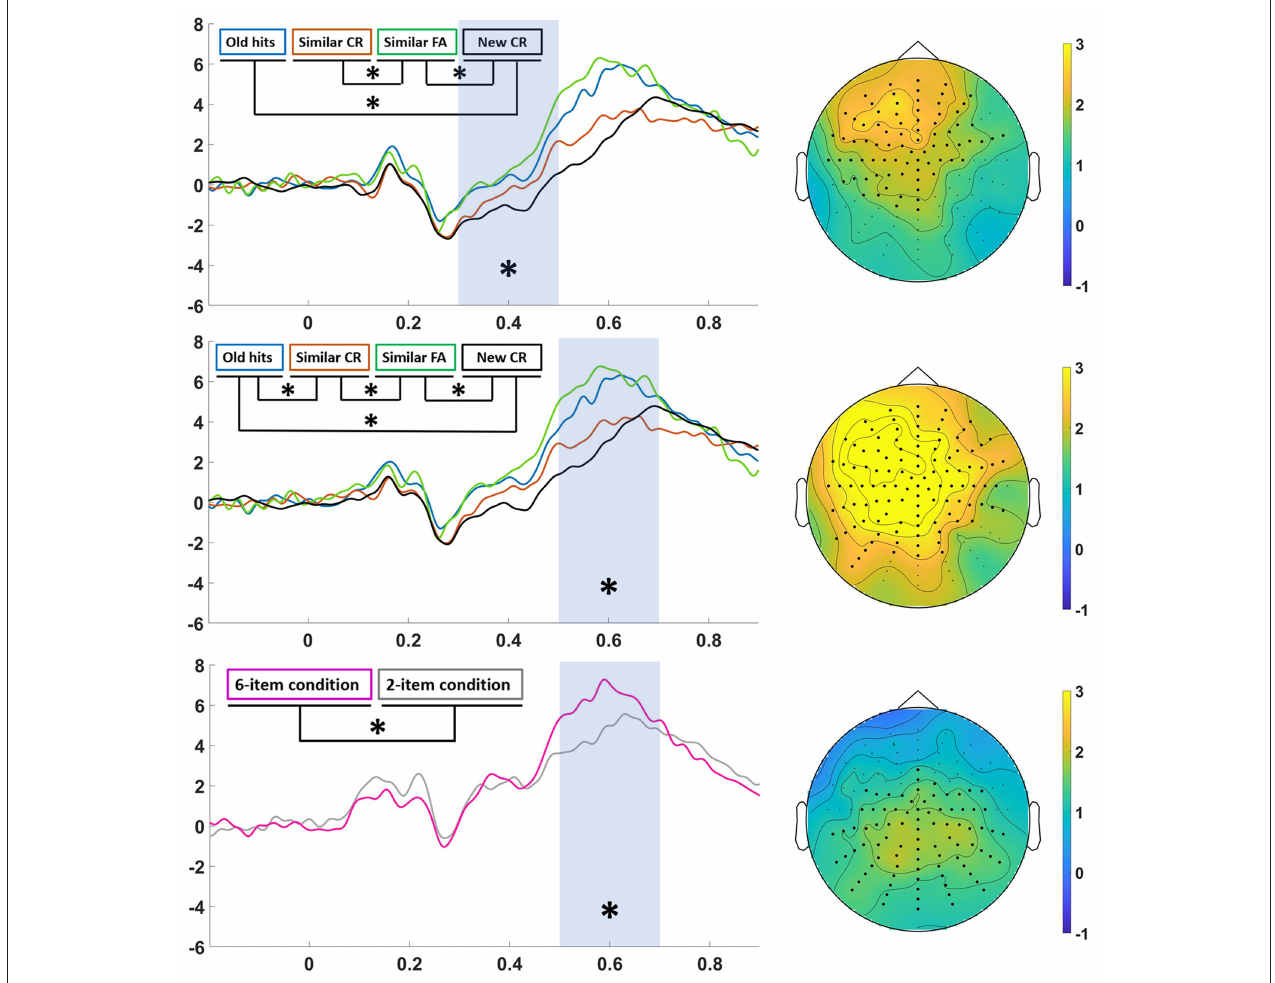
FIGURE 4 | Analysis in the 20-min group. Significant differences are marked with an asterisk in the ERPs and with black circles in the topography. Left: ERPs from “old hits” (blue line), “similar CR” (red line), “similar FA” (green line) and “new CR” (black line) in the 300–500ms (top) and 500–700ms (middle) time window, and ERPs from “6-item condition” (pink line) and “2-item condition” (gray line) in the 500–700ms time window (down). Right: topographic map of the grand-average of “similar FA-new CR” in the 300–500ms time window (top), “similar FA-new CR” (middle) in the 500–700ms time window (middle), and “6-item condition-2-item condition” in the 500–700ms time window